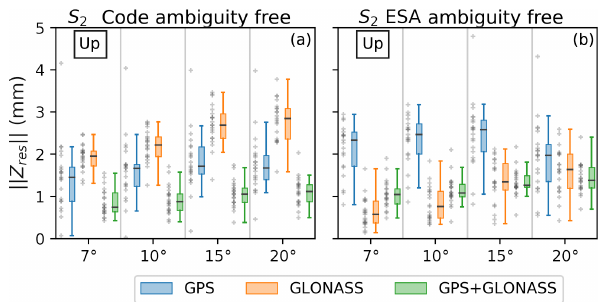
Figure 7. Average uncertainties (1 σ ) for OTL amplitudes computed across eight OTL constituents per products (stipple) and process- ing modes or constellation (colour): GLONASS (orange) and GPS (blue) modes show higher 1 σ uncertainties, while GPS-only AR and combined GPS+GLONASS (green) show minimum 1 σ uncer- tainties with the exception of